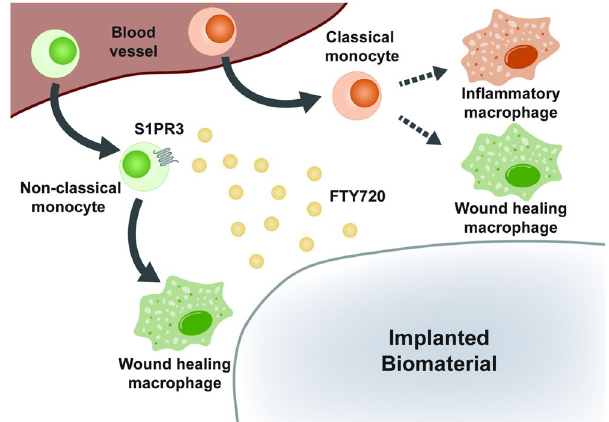
Figure 9. Local FTY720 release recruits biased progenitors of wound healing macrophages to inflamed tissue. Circulating non-classical S1PR3 hi monocytes are recruited by local delivery of FTY720 from a material implanted within an injury site. Upon entrance into inflamed tissue, non-classical monocytes give rise to alternatively activated, wound healing macrophages. Conversely, classical monocytes differentiate into both inflammatory and wound healing